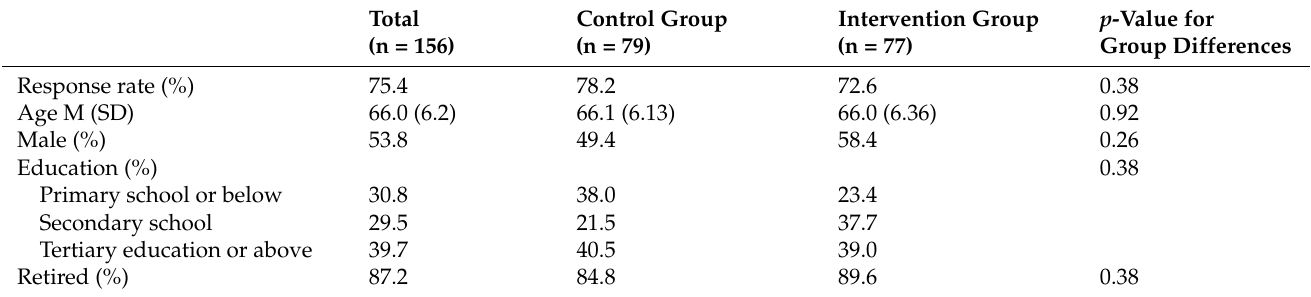
Table 1. Characteristics of the respondent patients by group.